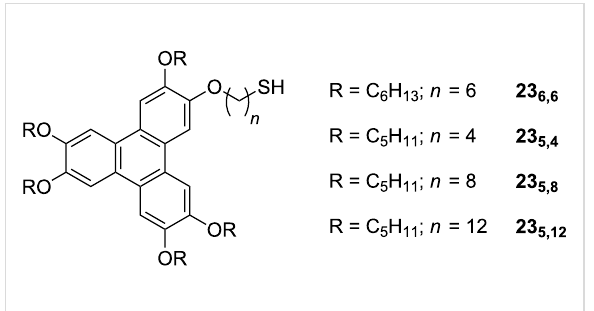
Figure 25: Chemical structures of the discotic mesogenic ligands used to coat NPs.